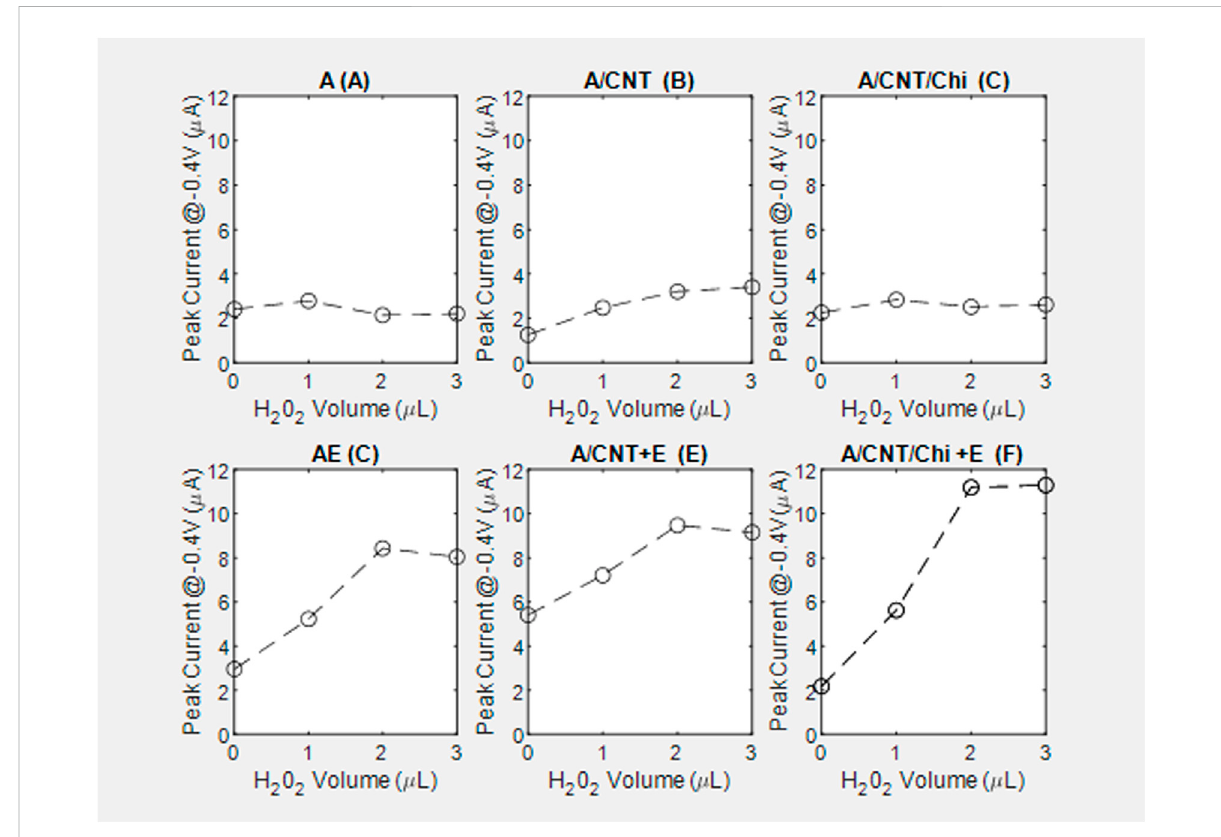
FIGURE 8 Peak current at − 0.4 V relative to the background signal from the voltagrams of nanocomposite biosensing fi lms, performed with a voltage sweep between 0.5 V and − 0.8 V at a rate of 100 mV/s on controls and corresponding reactive catalase immobilized slabs in the top and bottom rows, respectively. Main plots capture substrate ranging from (0 – 3 µL) while insets contrast the overlay between (0and3 µL ): (A1) alginate slabs (A) , (A2, inset); (B) alginate slabs with CNTs (A/CNT), (B2, inset); (C) alginate slabs with CNTs and chitosan (A/CNT/Chi), (C2,inset); (D) alginate slabs withCAT(AE),(D2,inset); (E) alginateslabswithCNTsandCAT(A/CNT+E),(E2,inset); (F) alginateslabswithCNTs,chitosanandCAT(A/CNT/Chi+E),